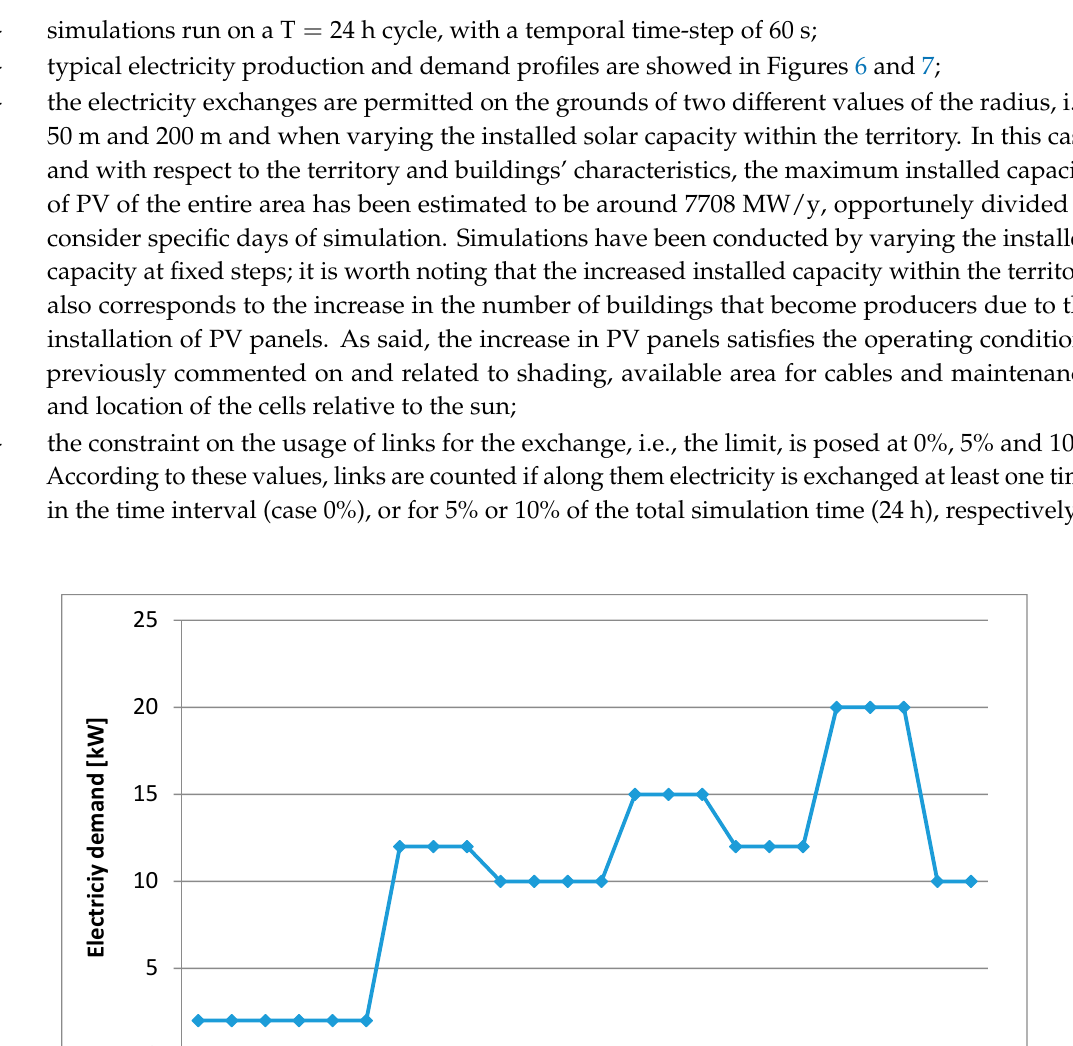
0510152025 Figure 6. An electricity demand profile for an agent. Figure 6. An electricity demand profile for an Figure 7. An electricity production profile of an agent equipped with PV panels. 4. Results and Discussion The performances of the distribution network are discussed on the grounds of the three indexes introduced in Section 2, i.e., the 𝑢𝑡𝑖𝑙𝑖𝑧𝑎𝑡𝑖𝑜𝑛 𝑟𝑎𝑡𝑒 , the 𝑒𝑥𝑐𝑒𝑠𝑠 and the 𝑐𝑒𝑛𝑡𝑟𝑎𝑙 𝑠𝑢𝑝𝑝𝑙𝑦 . As a brief reminder, the 𝑢𝑡𝑖𝑙𝑖𝑧𝑎𝑡𝑖𝑜𝑛 𝑟𝑎𝑡𝑒 measures the number of links effectively used for the exchange on the total possible number of links established by the radius . The 𝑒𝑥𝑐𝑒𝑠𝑠 calculates the electricity produced but neither consumed nor distributed (nor stored, as in scenario 2) and the 𝑐𝑒𝑛𝑡𝑟𝑎𝑙 𝑠𝑢𝑝𝑝𝑙𝑦 measures the amount of electricity still requested to the traditional power plant despite the distribution among agents. All results are plotted by varying the installed solar capacity within the territory and comparing the two scenarios for the chosen values of the radius . The 𝑢𝑡𝑖𝑙𝑖𝑧𝑎𝑡𝑖𝑜𝑛 𝑟𝑎𝑡𝑒 for both scenarios is plotted in Figure 8. Going into details, Figure 8a illustrates the trends of the index when limit = 0% , i.e., when no restrictions in the counting of the exploited links are introduced. As an immediate evidence, a significant scenario-based diversification